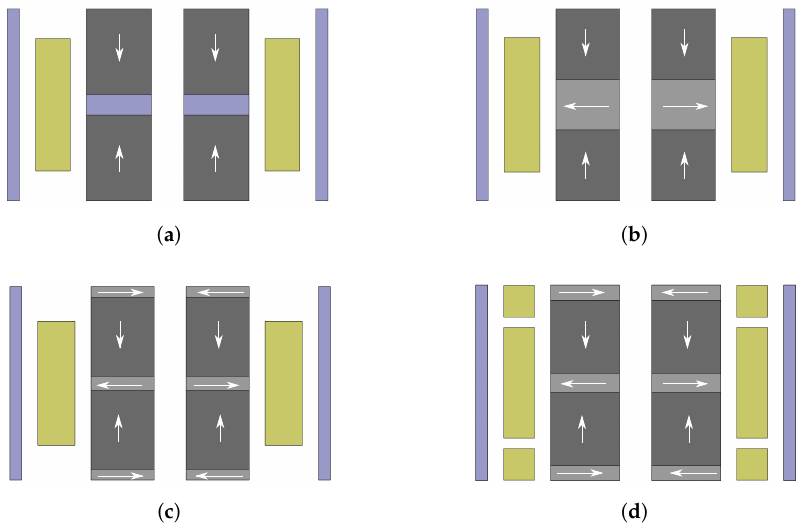
Figure 11. Resulting structures of the four configurations after electromagnetic coupling maximiza- tion: ( a ) Configuration DM1S1C. ( b ) Configuration H3M1C. ( c ) Configuration H5M1C. ( d ) Configu- ration H5M3C.